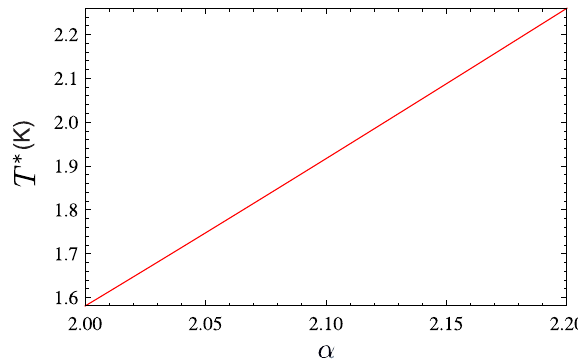
FIG. 2. Activation temperature T (cid:2) as a function of the coupling α for N ¼ 4 and Λ ∼ 3 . 0 f